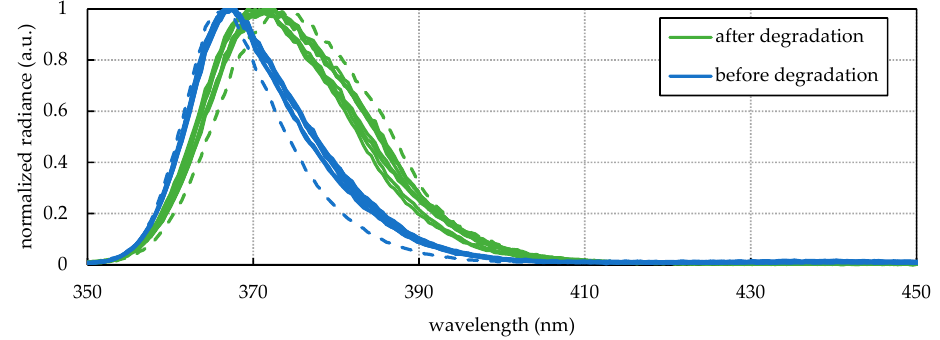
Figure 13. Spectral LED radiance, normalized to the maximum of each LED, before (blue) and after (green) climatic chamber tests. The dashed lines show outliers.